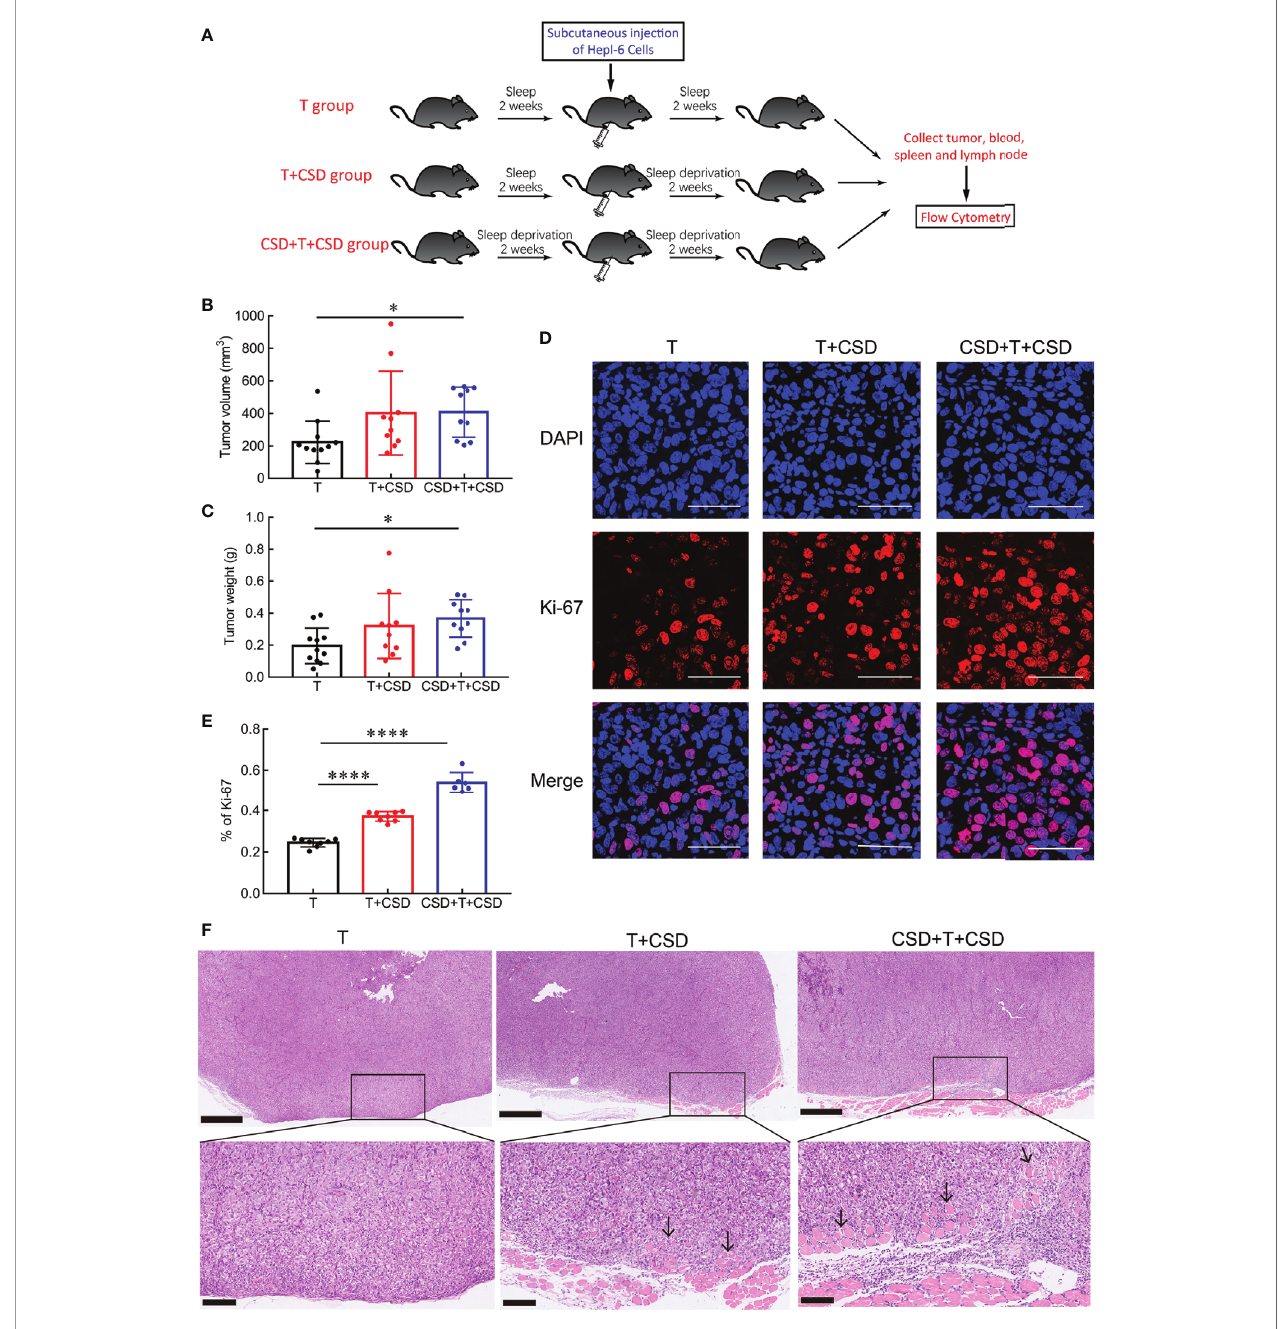
FIGURE 3 | CSD promotes tumor growth, proliferation, and invasion. (A) Schematic illustration of the experimental groups. (B, C) CSD for 2 weeks before and after subcutaneous injection of Hep1-6 cells (CSD + T + CSD) signi fi cantly increased tumor size (B) and weight (C) compared to the normal sleep group (T). Mice in the T + CSD group were subjected to CSD for 2 weeks only after tumor implantation (n = 10 – 11 per group). (D) Representative immuno fl uorescence images of 4 ′ ,6- diamidino-2-phenylindole (DAPI)-stained nuclei (blue) and Ki-67 immunolabeling (red) in tumor sections from different groups and merged images at 630× magni fi cation. Scale bars = 50 m m. (E) Quanti fi cation of the percentage of Ki-67-positive cells in tumor tissues from mice in the T, T + CSD, and CSD + T + CSD groups (n = 6 – 8 per group). (F) HE staining of subcutaneous tumor tissues. Tumor cells were observed to penetrate and in fi ltrate into adjacent muscle tissue in the T + CSD and CSD + T + CSD groups (arrows). Upper panels: 50×, scale bar = 500 m m; lower panels: 200×, scale bar = 100 m m. Data are presented as mean ± SEM. * p < 0.05, **** p <